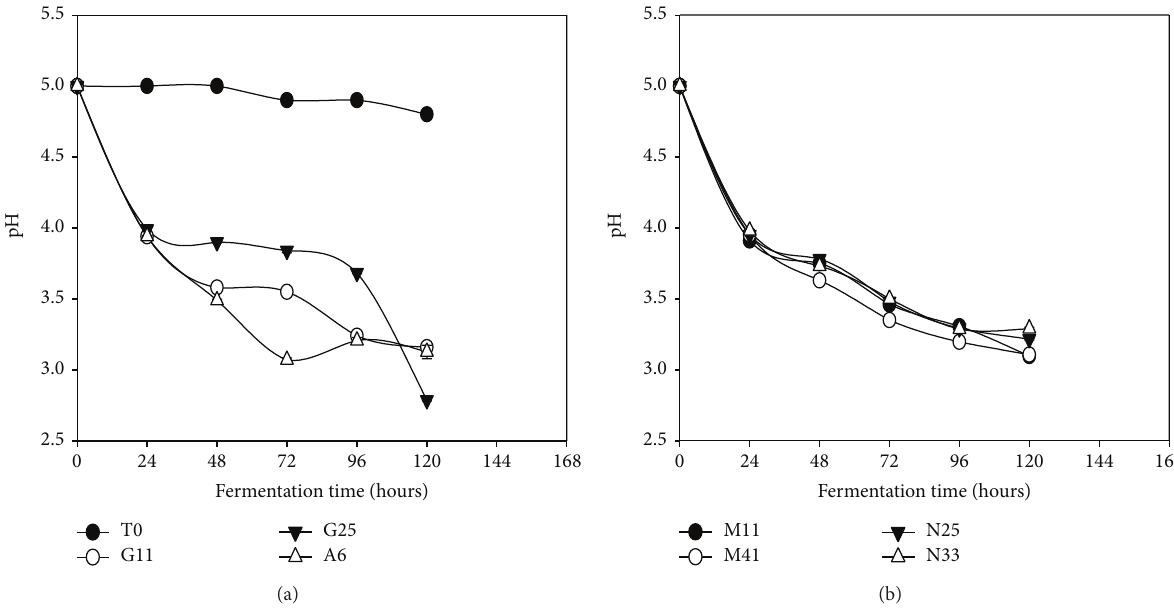
Figure 2: Evolution of pH in the Kutukutu during fermentation by the various LAB at 25 ∘ C (T0 = control; G11 = L. brevis G11; G25 = L. brevis G25; A6 = L. plantarum A6; M11 = L. buchneri M1; M41 = L. cellobiosus M41; N33 = L. fermentum N33; N25 = L. fermentum N25).